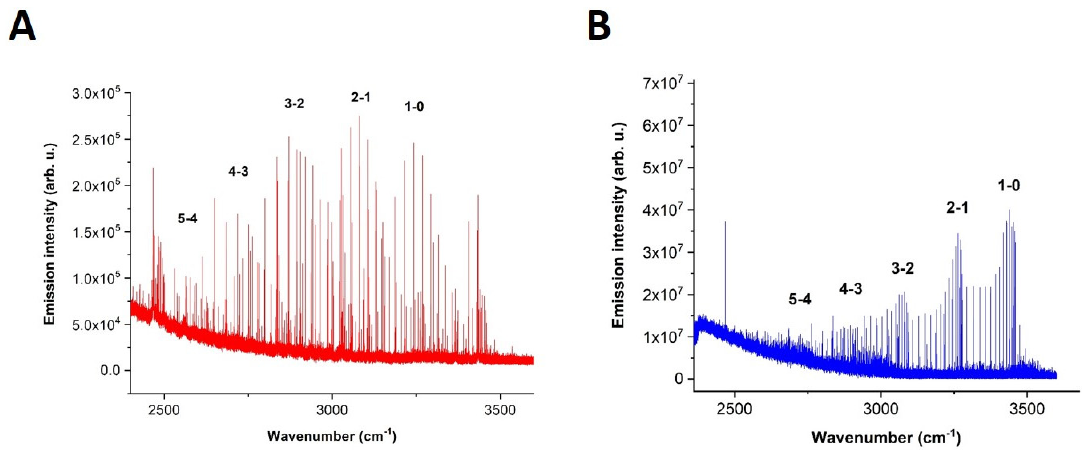
Figure 14. Panel ( A )—averaged spectrum of H 2 + N 2 discharge. Panel ( B )—averaged spectrum of NH 3 + N 2 + Ar discharge.